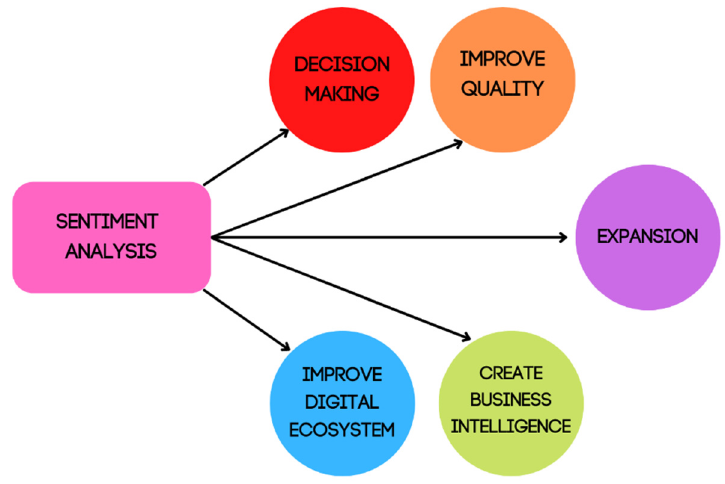
Figure 1. Benefits of sentiment analysis as business process reengineering tools.